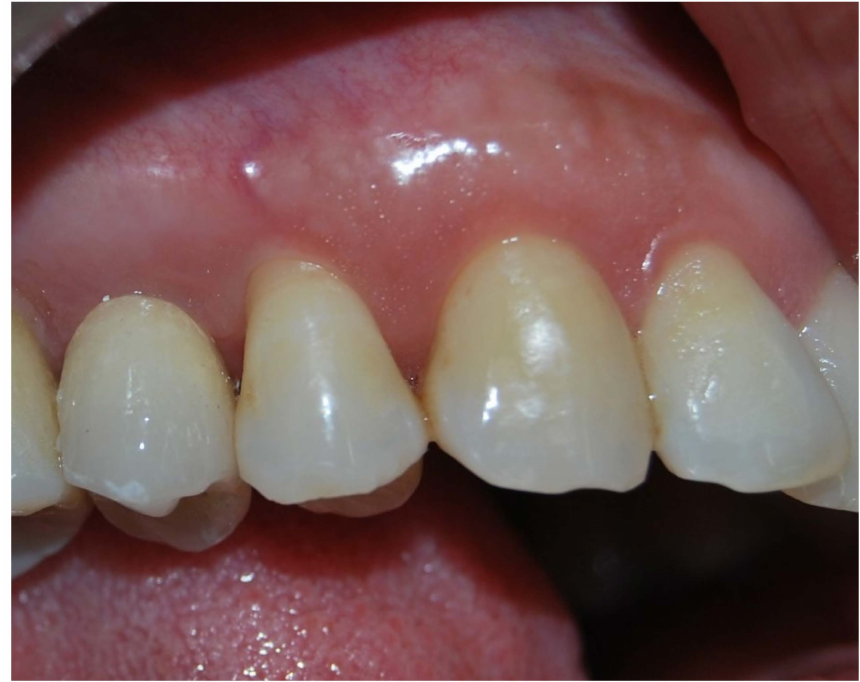
Figure 2. Five-year clinical follow-up. Clinical photo 5 years after